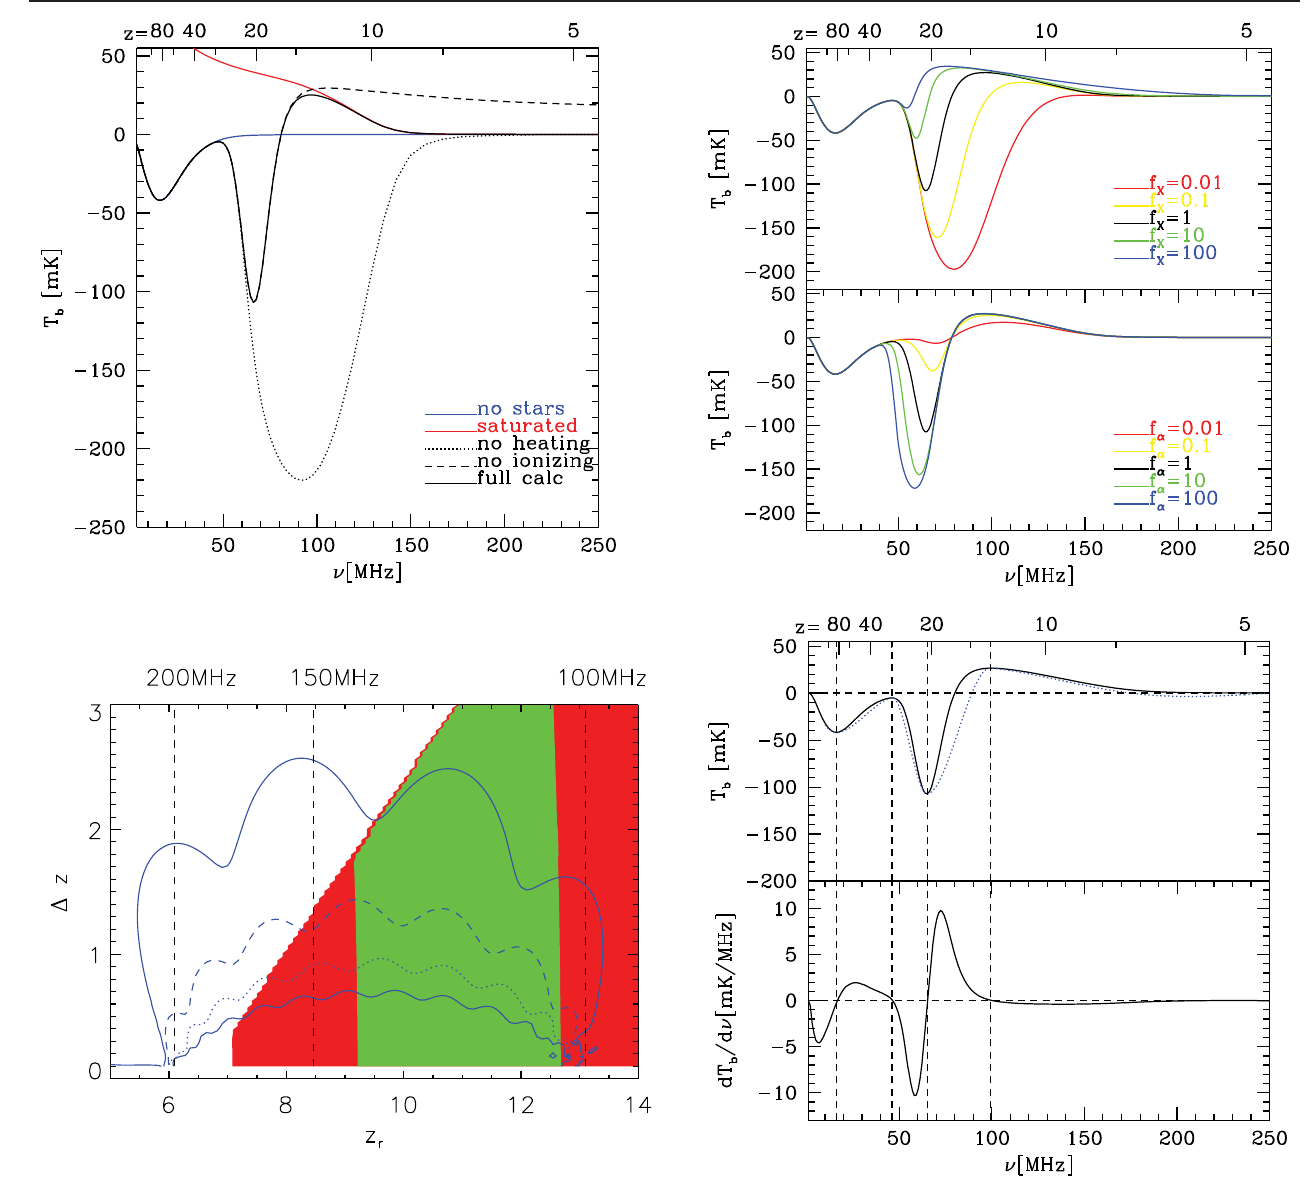
FIG. 31. Representations from peer-reviewed journal article. Image credit: Pritchard and Loeb